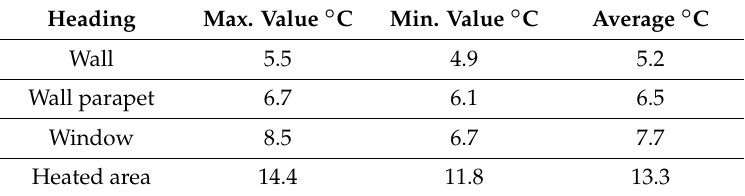
Table 4. Characteristic values of the measured temperature.